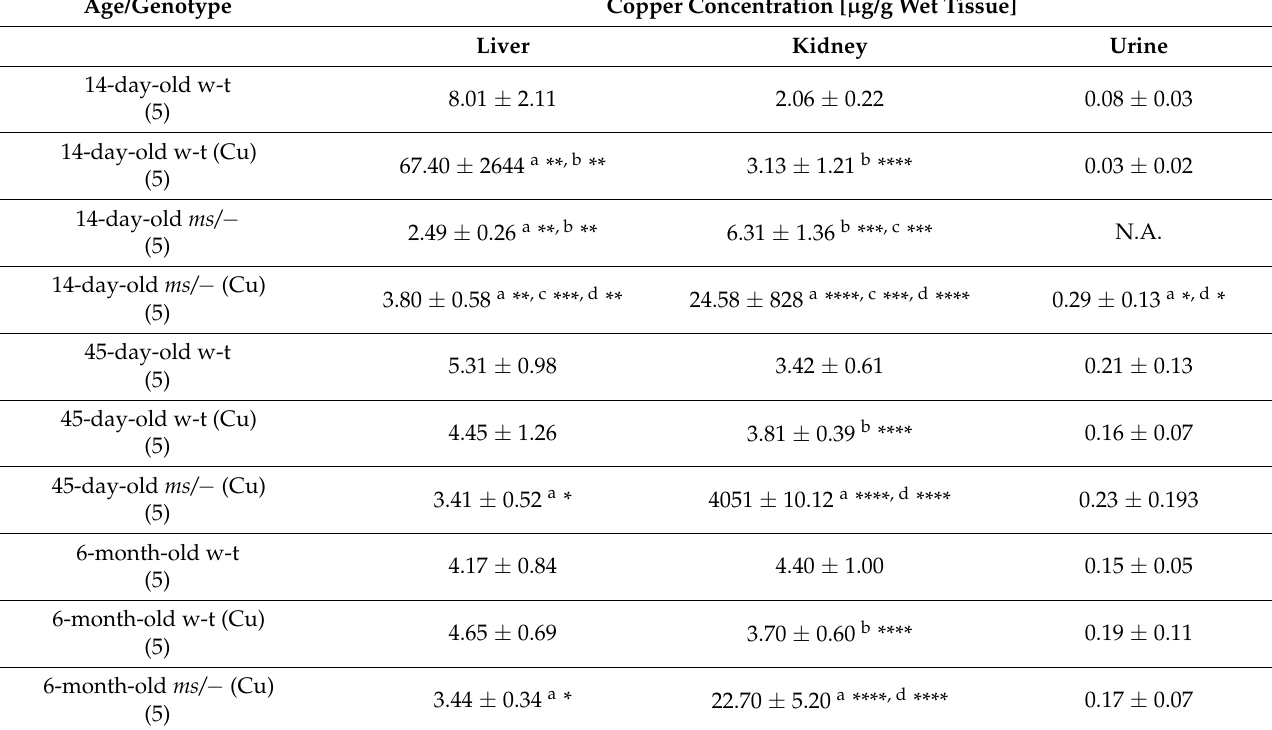
Table 1. Copper concentration in the liver, kidney and urine of wild-type (w-t) and mosaic mutant mice measured by atomic absorption spectrophotometry (AAS). Wild-type and mosaic mutant mice were treated with subcutaneous injections of 50 µ L of 0.01% CuCl 2 (Sigma) solution every 2 days from day 2 to day 44 after birth. The total amount of copper administrated per animal during this period was 100 µ g. Untreated mosaic mutant males die at about day 16 after birth but copper therapy reduced the lethal effect of mutation. Abbreviations: a —significantly different from w-t (control group); b —significantly different from ms/ − (Cu) (CuCl 2 -injected mosaic mutants group); c —significantly different from ms/ − (untreated mosaic mutants group); d —significantly different from w-t (CuCl 2 -injected, wild-type group); p < 0.05—*; p < 0.01—**; p < 0.001—***; p < 0.0001—****;